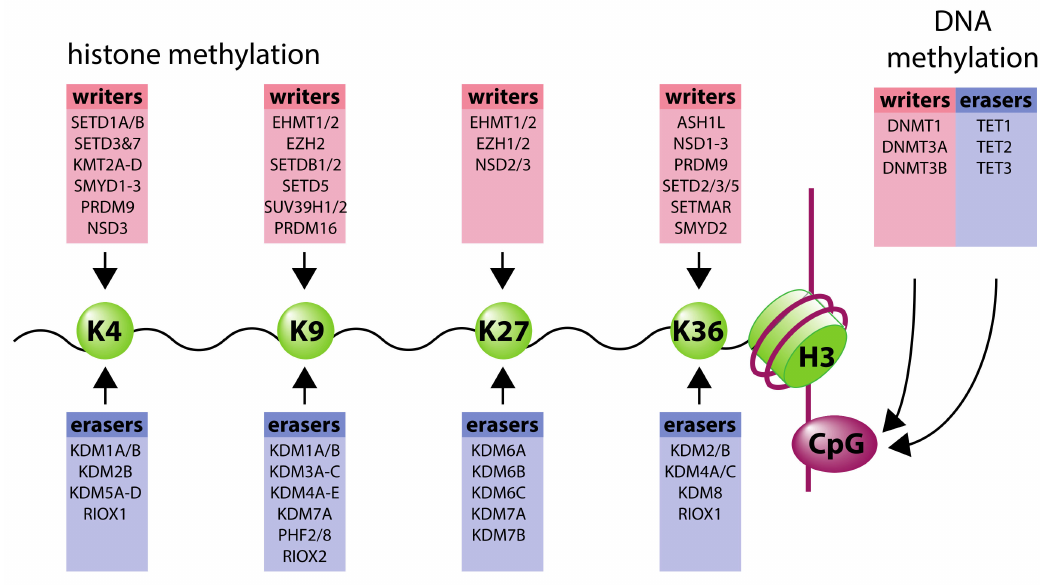
Figure 2. Writers and erasers of histone H3 methyl lysine, and DNA CpG